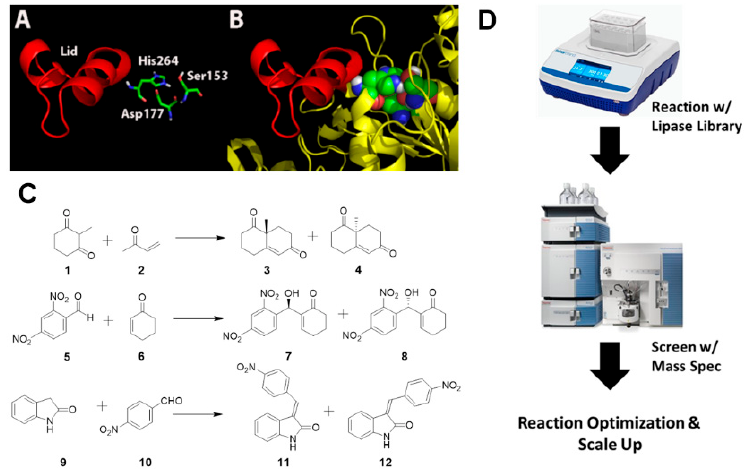
Figure 1. Porcine pancreatic lipase (PPL) is a model lipase for biocatalysis of C-C bond forming reactions. The active site (( A ) colored spheres) of PPL is presumed to catalyze the C-C bond forming reactions via carbonyl binding and activation in an oxy-anion hole. The lid domain (( A ) red ribbon) is presumed to undergo interfacial activation (assuming an open conformation in more hydrophobic solvents). ( B ) Both lid domain and active shown in context of 3D protein ribbon structure (PDB ID 1ETH). ( C ) Examples of carbon-carbon bond forming reactions catalyzed by lipases (Robinson annulation: reaction of cyclohexanedione 1 and methyl vinyl ketone 2 provides bicyclic Wieland–Miescher ketone products 3 and 4 ; Morita–Baylis–Hillman: reaction of dinitrobenzaldehyde 5 and cyclohexenone 6 provides MBH products 7 and 8 ; and Knoevenagel condensation: reaction of 2-oxindole 9 and nitrobenzaldehyde 10 provides KC products 11 and 12 ). ( D ) Overview of screening